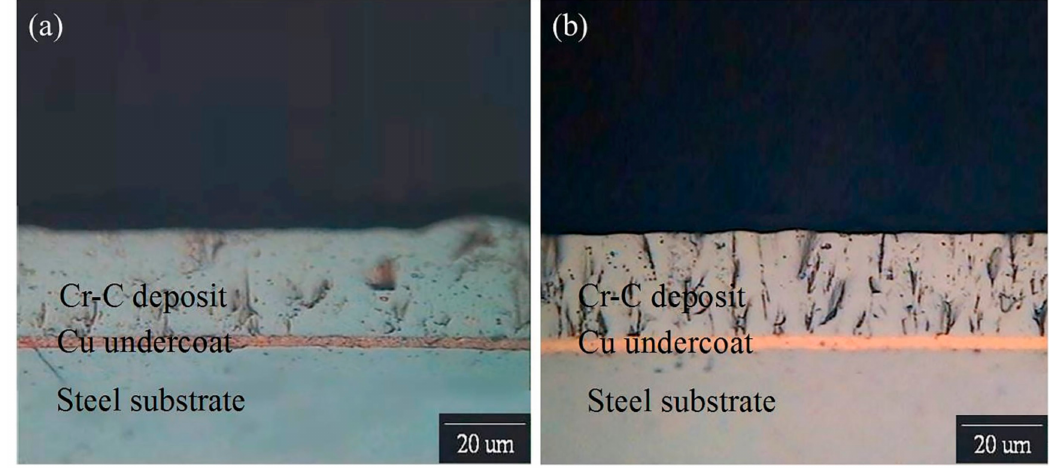
Figure 3. Cross sectional micrographs of the ( a ) non-heated and ( b ) heat-hardened Cr–C / Cu-coated